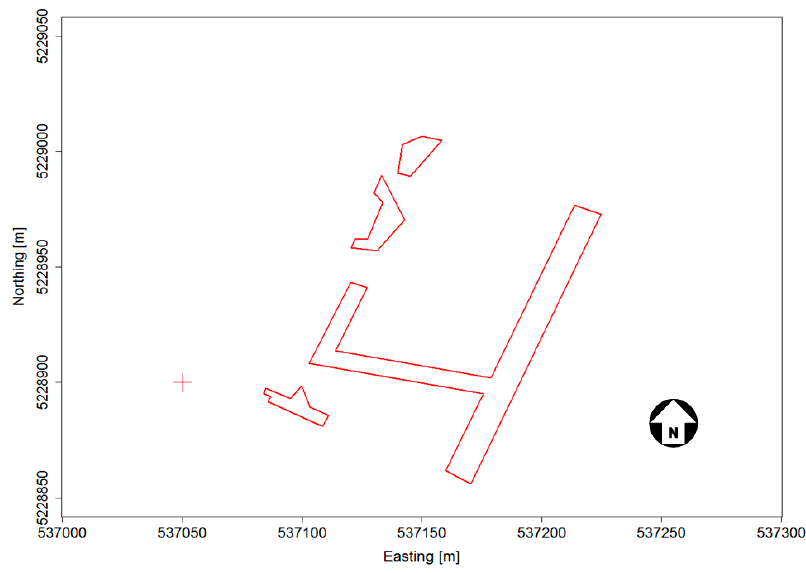
Figure 17. Enhanced vector map of class “road and parking lot” (Level 2).